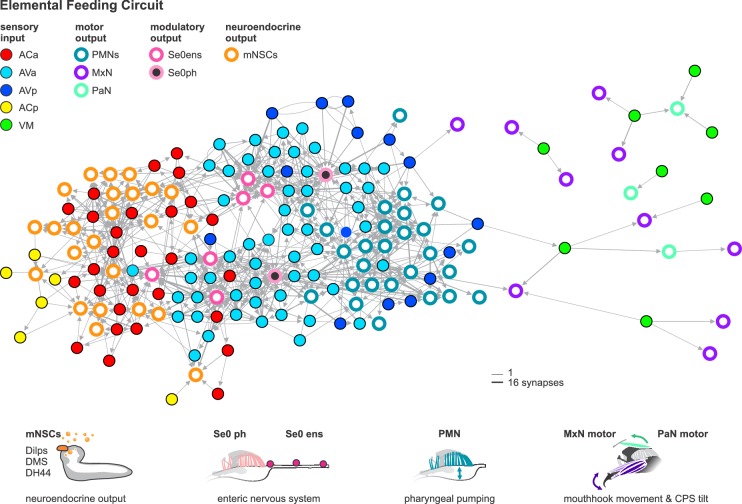
The elemental feeding circuit.Force-directed connectivity graph of all axo-dendritic connections between sensory neurons and output neurons. Each node represents a single neuron. Nodes are colored based on their broader identity (sensory compartment, motor, modulatory and neuroendocrine groups). Effectors of neurosecretory, modulatory and motor output neurons (lower panel): mNSCs target the ring gland and release Drosophila insulin-like-peptides (Dilps), Dromyosuppressin (DMS) and diuretic hormone 44 (DH44); Pharyngeal motor and Se0ph neurons target the pharyngeal pump; Se0ens neurons target the enteric nervous system; MxN motor neurons control mouth hook movement, labial retraction and opening of the salivary gland ductus; PaN motor neurons tilt the whole CPS.